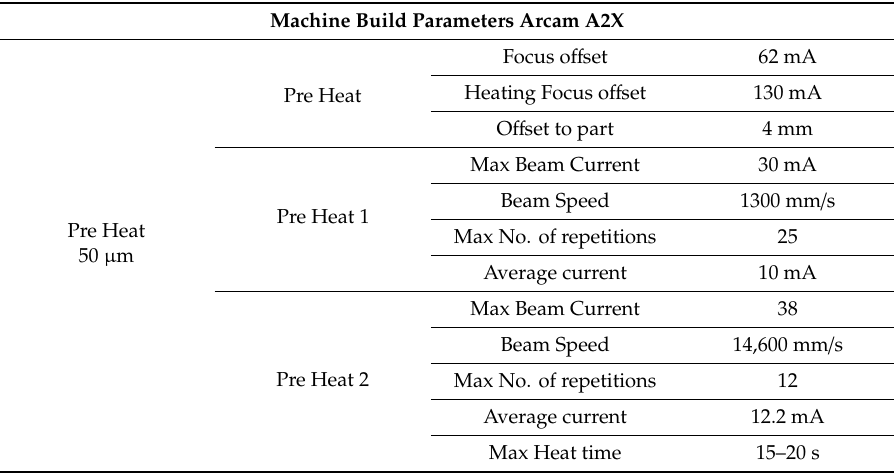
Table 1. Build Parameters for Arcam A2X